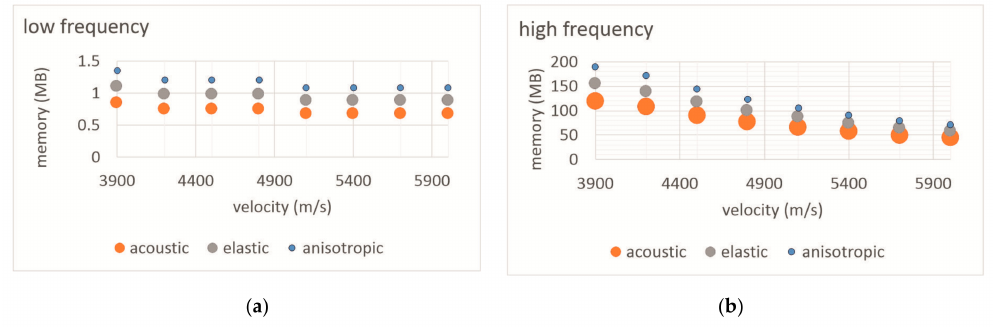
Figure 13. The relationships between the memory workout and velocity of the slowest wave for: low ( a ) and high ( b ) frequencies of the source wavelet.